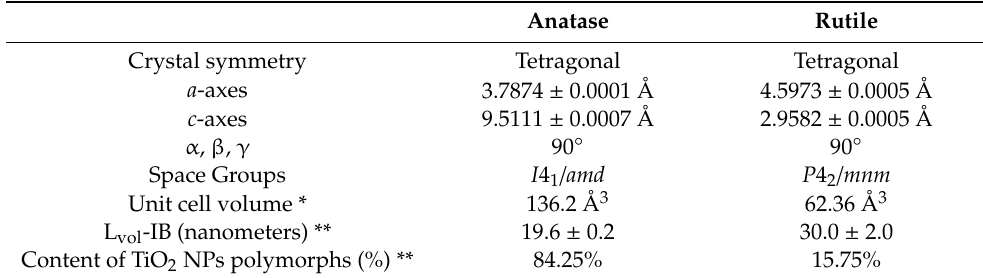
Figure 3. ( a ) Scanning electron microscopy of TiO 2 -NPs, ( b ) X-ray di ff raction analysis confirmed that TiO 2 -NPs have anatase (A) and rutile (R) polymorphic modification. Table 3. X-ray di ff raction analysis of TiO 2 -NPs polymorphic modifications, with estimated symmetry and unit cell